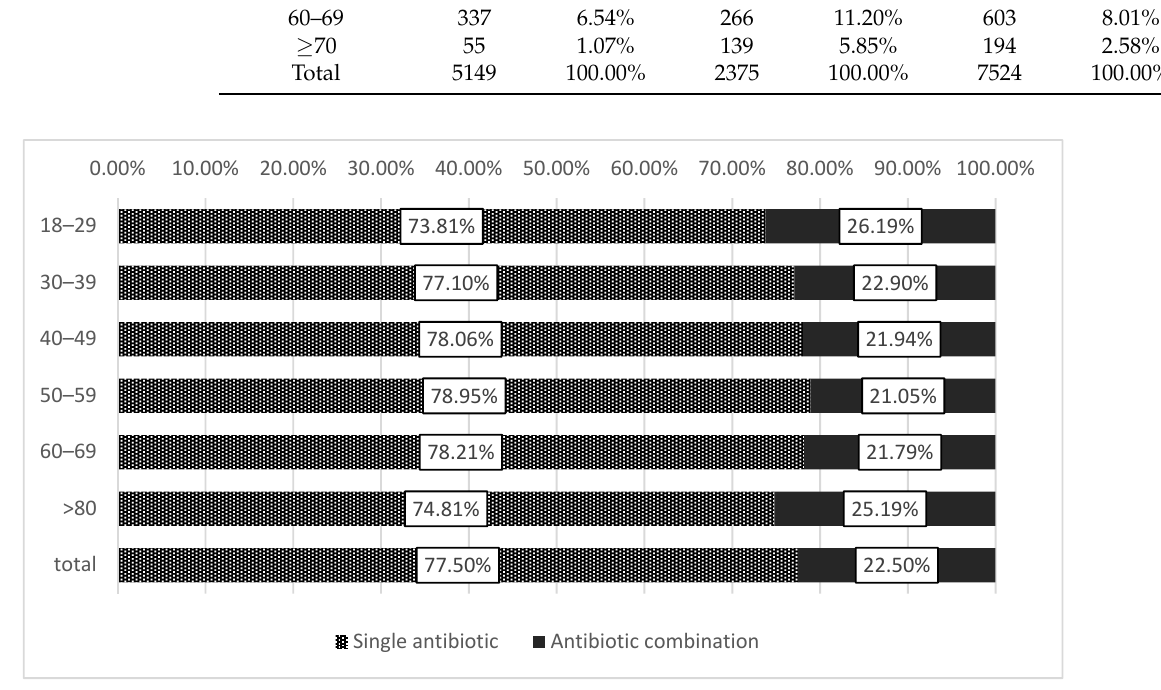
Figure 1. Prevalence of dispensing combination antibiotic therapy in patients of different age groups (combination antibiotic therapy defined as receiving a prescription for two or more different antibi- otics during one visit).